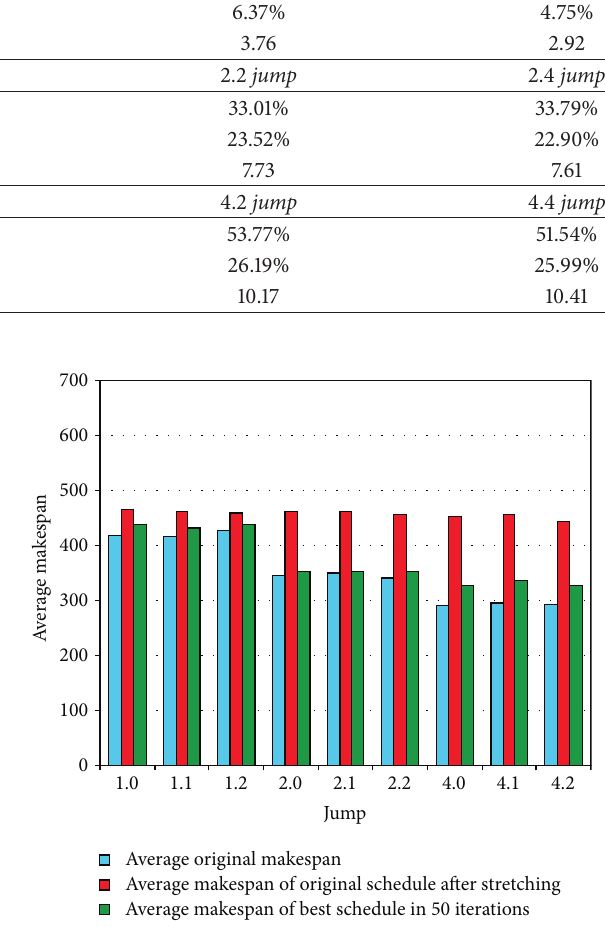
Figure 16: Performance for DAGs with different jump